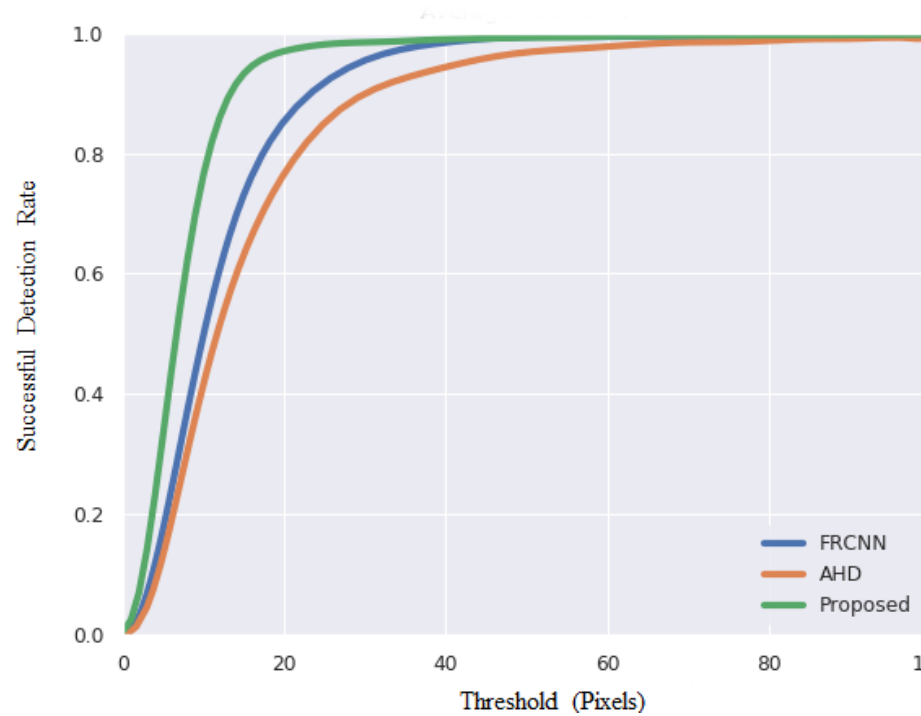
Figure 13. Comparison of fingertip detection under varying threshold values.